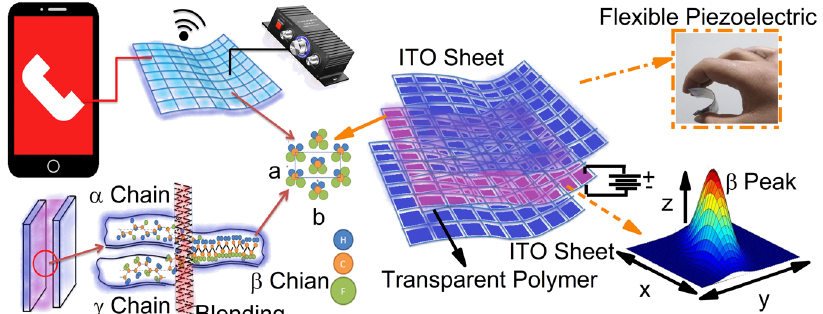
Fig. 1 Piezoelectric transducer. The schematic depiction of a fl exible and transparent piezoelectric loudspeaker made by sandwiching transparent polymers between two ITO electrodes. Also shown is the backbone beta chain structure of P(VDF-TrFE), synthesized as a result of a reaction of alpha and gamma chains of two different polymers during blending.